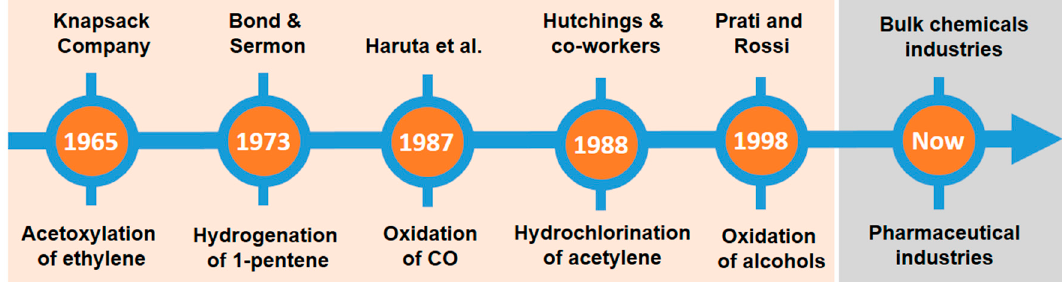
Figure 1. The historical development map of gold catalysts for the last five decades.